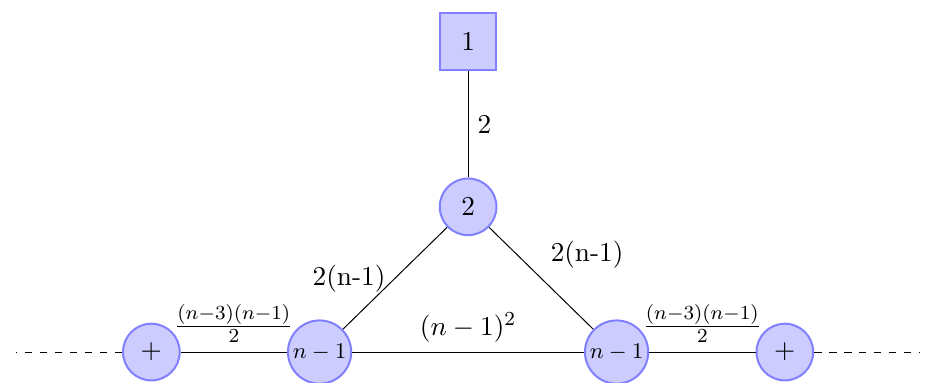
surplus contributions to (cid:1) 2